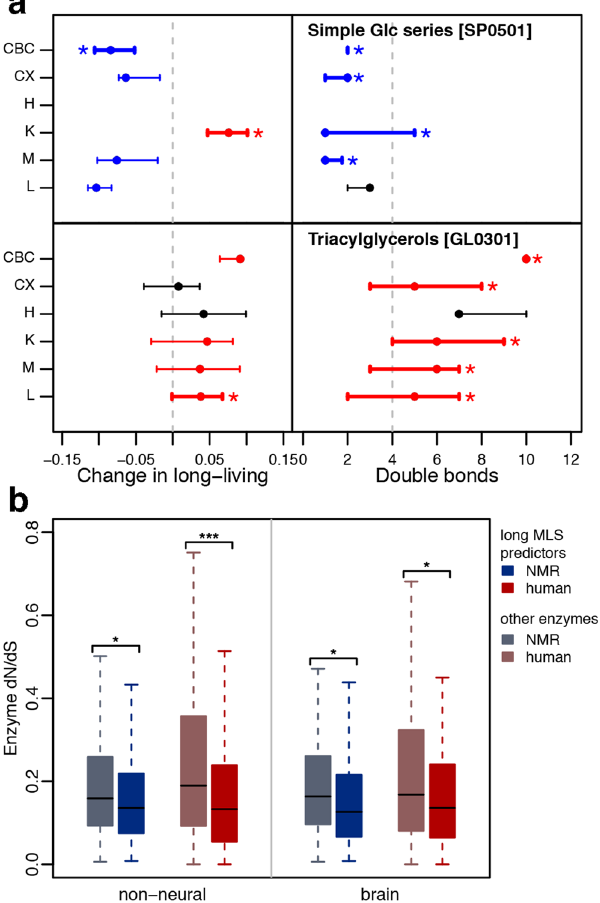
Figure 3. Long-lifespan related lipids. ( a ) Concentration level change and double bond distribution of long MLS predictors belonging to two lipid sub-classes in six tissues. Change in the concentration level is calculated as the difference between mean of the concentration levels in the long-living species and all other species in each of the clades. Left panel shows median concentration change of long MLS predictors belonging to simple Glc series and triacylglycerol lipid sub-classes in long-living species. The error bars show the 0.25 to 0.75 inter-quintile intervals. Significant concentration shift towards lower and higher values in long-living species is indicated by blue and red colors, respectively. Significant enrichment of MLS predictors among detected compounds in a given lipid sub-class is shown by thick lines and asterisks. The vertical dashed line shows the median concentration change for all long MLS predictors. Right panel shows the median double bond number and its 0.25 to 0.75 inter-quintile intervals for the same lipid sub-classes as in the left panel. Significantly higher or lower number of double bonds in a given lipid group is shown by red and blue color respectively, as well as thick lines and asterisks. The vertical dashed line shows the median number of double bonds in all long MLS predictors. ( b ) Enzyme DNA sequence variation. Distributions of the dN/dS values of the enzymes linked to the lipid predictors of long MLS (darker colors), and the enzymes linked to other lipids detected in our dataset (lighter colors), in brain and non-neural tissues (liver, muscle, and kidney) in the long-living species. Asterisks indicate p-value range * p < 0.05, ** p < 0.01, *** p <